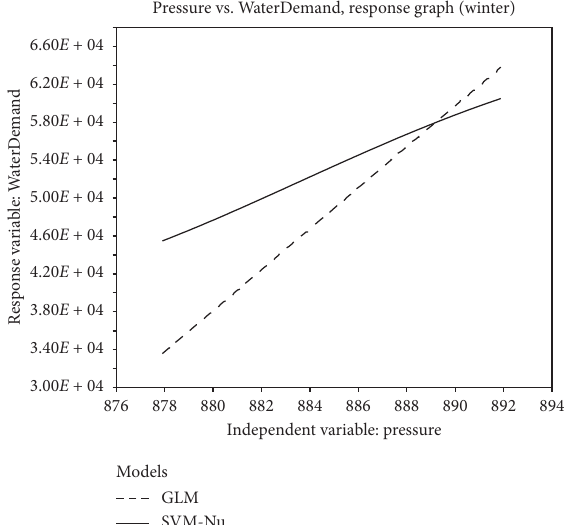
Figure 14: The reaction of water consumption to air pressure with winter conditions using GLM and SVM-Nu